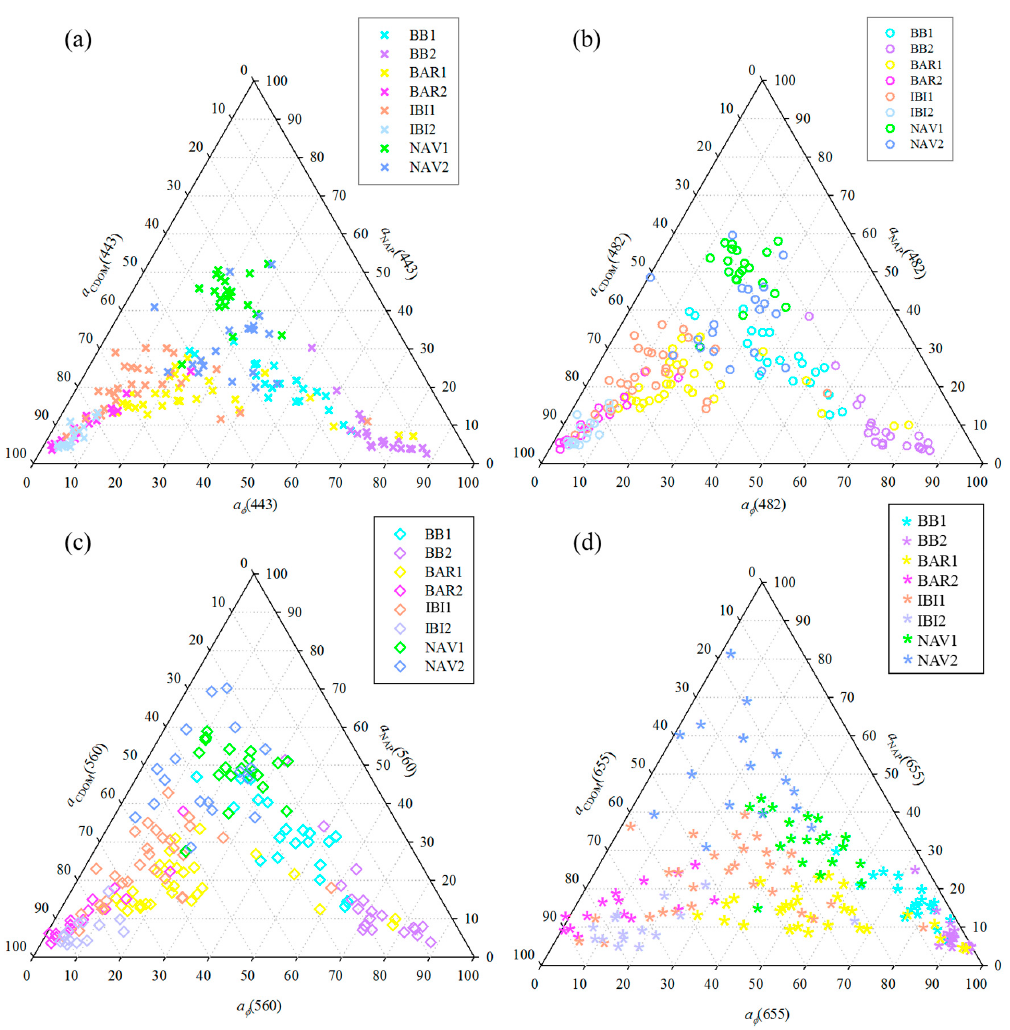
Figure 6. Ternary diagrams showing the contribution (%) of absorption coefficients to a t-w at ( a ) 443 nm; ( b ) 482 nm; ( c ) 560 nm; and ( d ) 655 nm from all of the field surveys (BB1, BB2, BAR1, BAR2, IBI1, IBI2, NAV1, and NAV2).